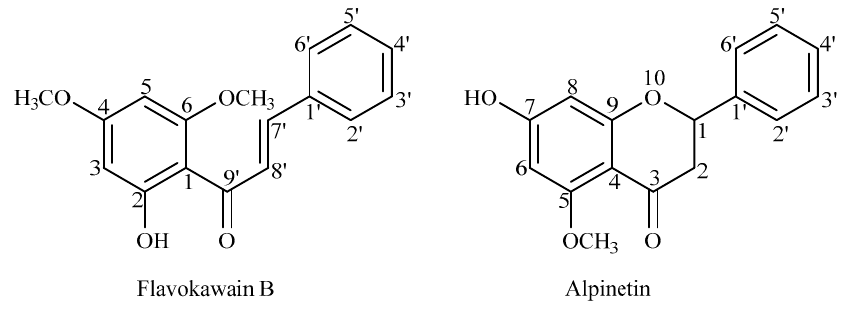
Figure 6. Skeletal structures of flavokawain B and alpinetin.